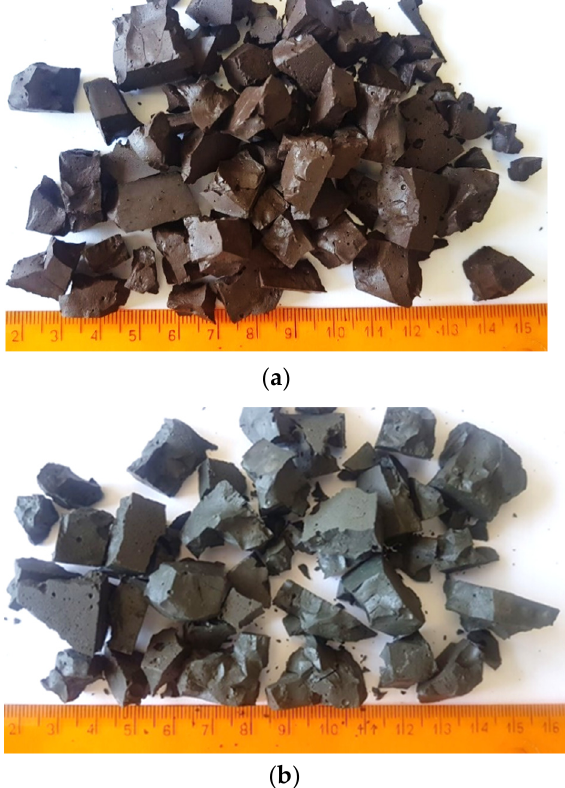
Figure 5. Geopolymer rock wool binder with the addition of bauxite (SG_B), fragmented form ( a ), Geopolymer Rock wool binder with the addition of Al 2 O 3 (SG_Al 2 O 3 ), fine form ( b ) .